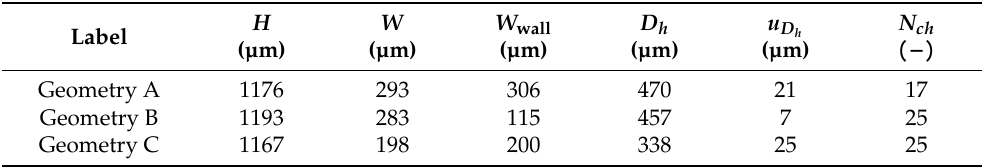
Table 3. Channel dimension measured by a confocal microscope. H = Height, W = Width, W wall = Separating wall thickness, D h = hydraulic diameter, u = uncertainty, and N ch = number of channels.